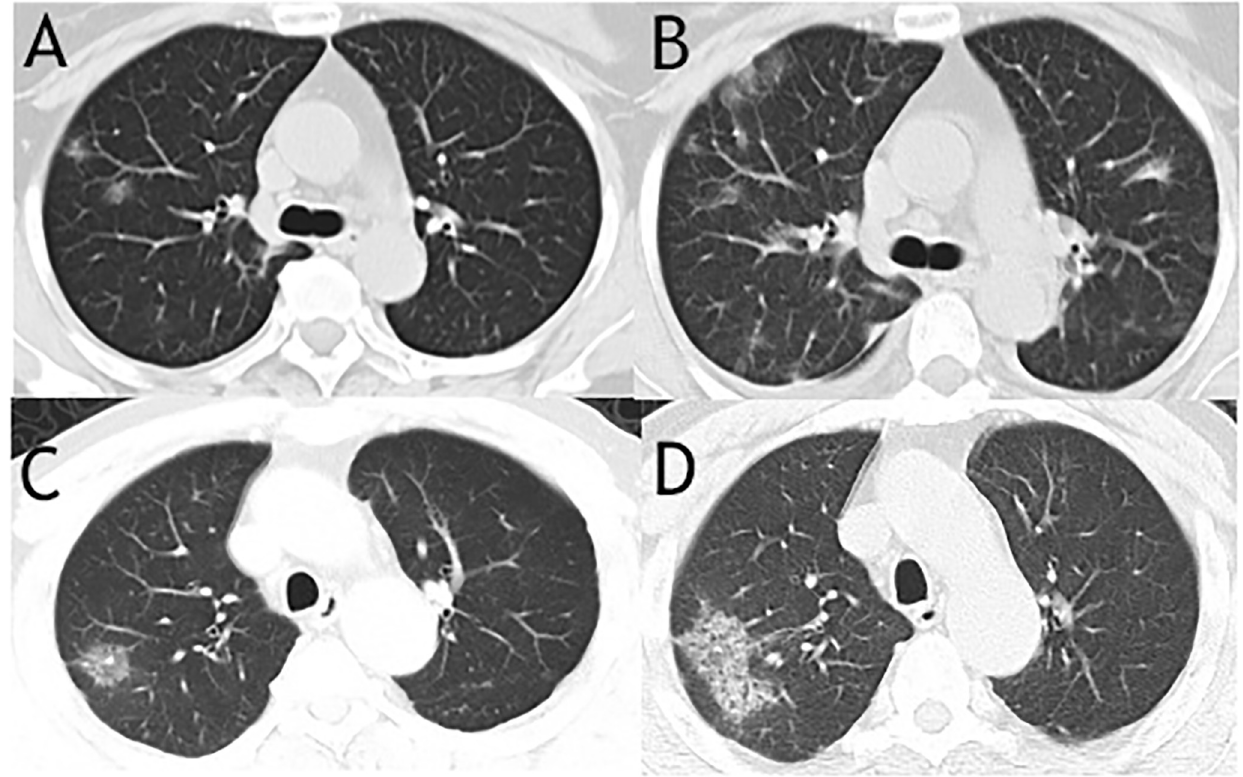
Fig 4. Two cases of CT images from survival group showed ground glass nodular opacities on admission and progressed to multiple patchy ground glass opacities on reexamination. The CT images of a 60-year-old woman on admission showed peripherally distributed focal ground glass nodular opacities in only right lung (A) and rechecked CT images showed expanded area of patchy ground glass opacities in both right and left lungs with reticular and interlobular septal thickening on 7 days later (B). Unilateral ground glass nodular opacity was found on CT images of a 64-year-old man from survival group (C) and progressed patchy ground glass opacities as well as interlobular septal thickening were seen after 4 days (D).